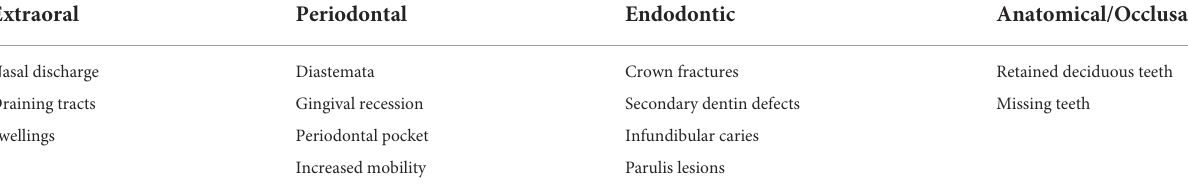
TABLE 1 Tabulated oral examination findings.